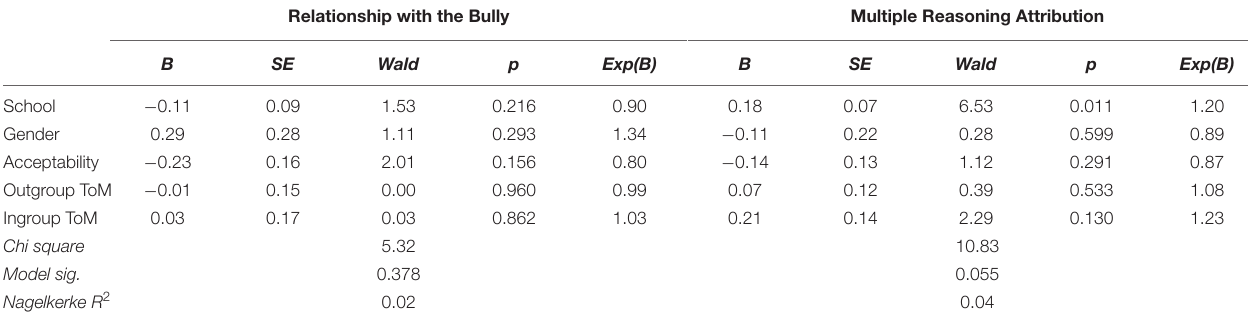
TABLE 6 | Binary logistic regression analyses for reasoning of group support to intergroup